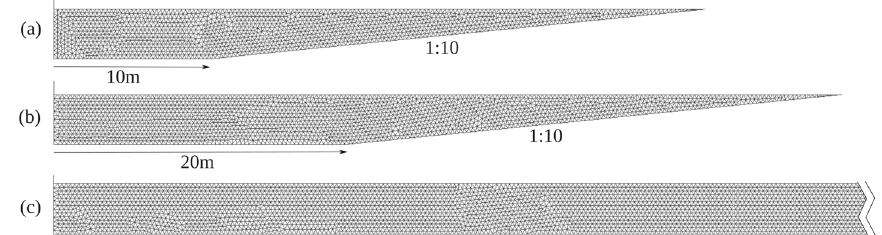
Fig. 8 Solitary wave example. a The mesh with interface at 10m, 2700 elements. b The mesh with interface at 20 m , 3800 elements. c Detail of the full mesh of the channel, 20000 elements. The slope has a dissipative effect and is acting as an absorbing